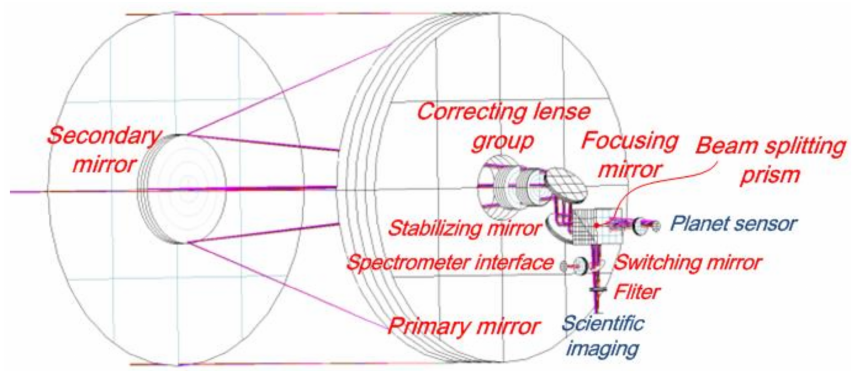
Figure 1. Optical